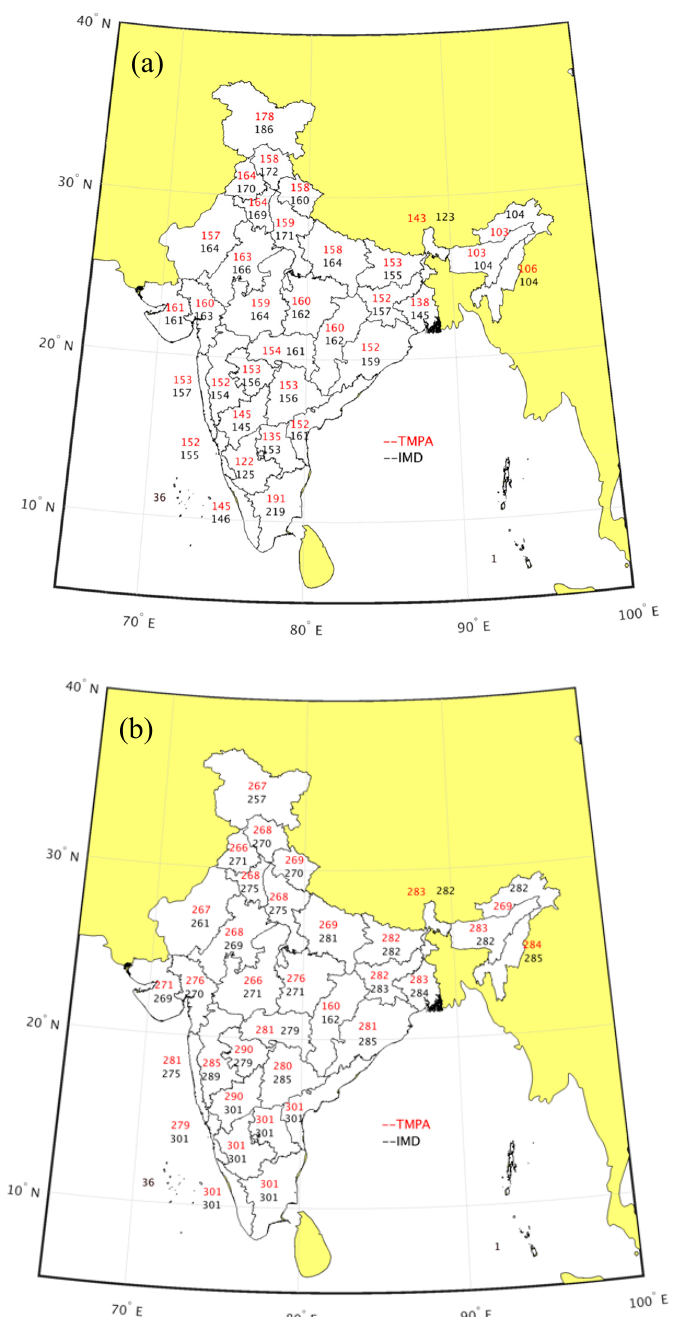
Figure 3. The climatological ( a ) onset and ( b ) demise dates in Julian days from IMD ( Black ) and TMPA ( Red ) are shown. These are statistically significant at 90% confidence interval according to t-test.